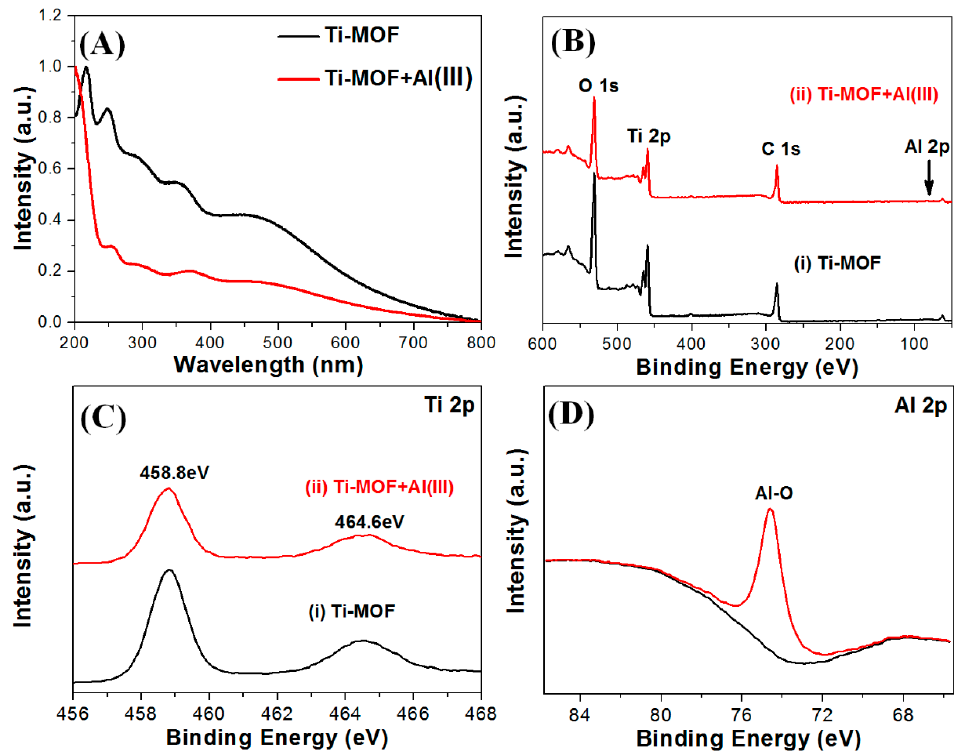
Figure 6. ( A ) UV-vis absorption spectra of Ti-MOF microflowers before and after Al(III) addition. ( B ) XPS spectra of Ti-MOF microflowers before and after Al(III) addition. ( C ) Ti2p spectra of Ti- MOF microflowers before and after adding Al(III). ( D ) Al2p spectra of Ti-MOF microflowers after addition of Al(III).